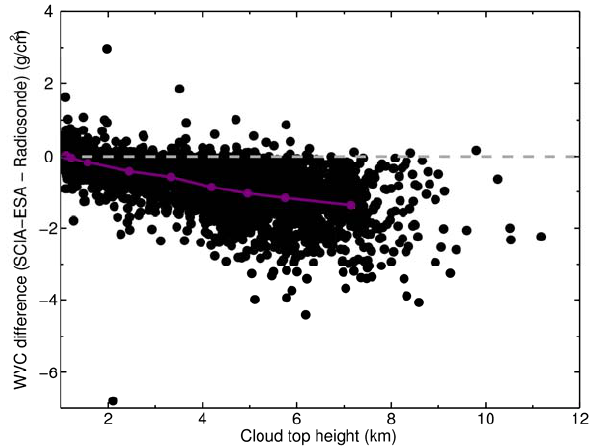
Fig. 5. SCIAMACHY-ESA and radiosonde WVC differences as a function of cloud top height, for all cases with a cloud cover fraction greater than or equal to 0.9. Purple points indicate the mean WVC difference for 9 bins with an equal number of data points (408 per bin). Note that the two bins for the smallest cloud top heights almost overlap.